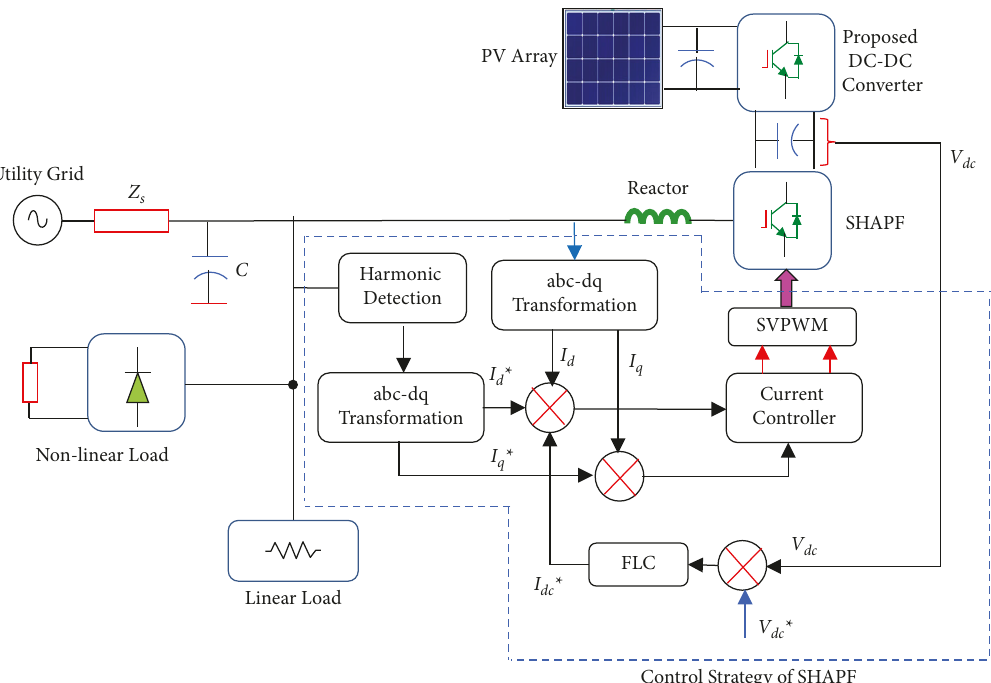
Figure 2: System architecture of the proposed MMPIFC boost converter operated components into the power line. The harmonic detection algorithm extracts the fundamental frequency components